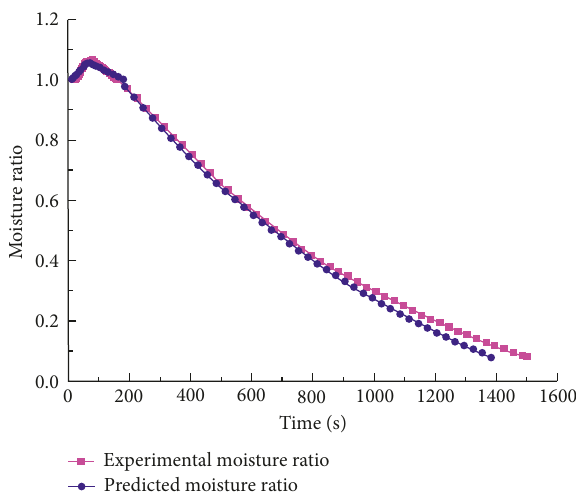
Figure 6: Verification of sludge superheated steam drying model.